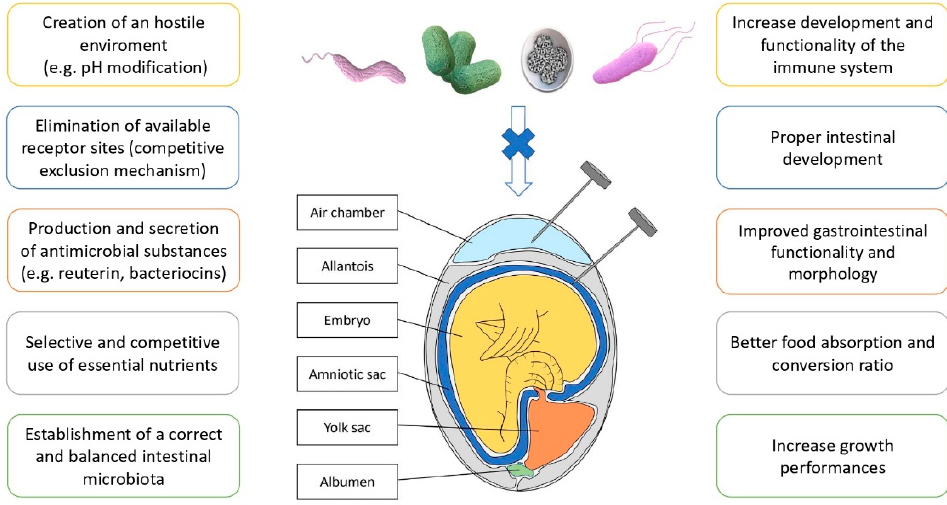
Figure 1. Benefits of in ovo inoculation of nutraceuticals and phytonutrient. Using in Ovo Inoculation Technique against GI Pathogens